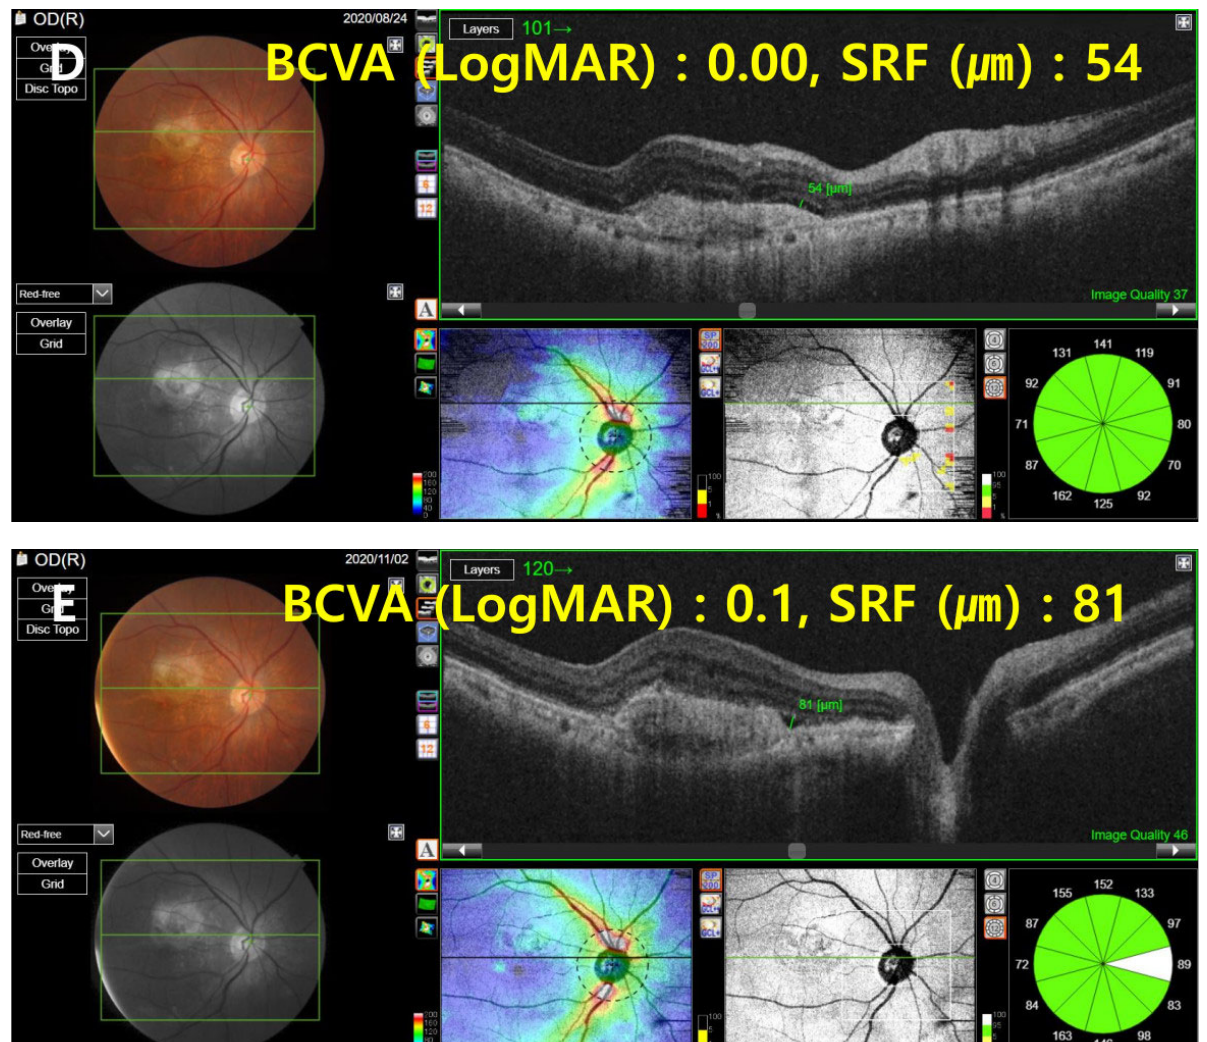
Figure 4. OCT change in a patient with neovascular age-related macular degeneration. ( A ) Baseline OCT image. ( B ) OCT image at the time of delayed injection. ( C ) Two months after the delayed injection. ( D ) Four months after the delayed injection. ( E ) Six months after the delayed injection. At the time of delayed injection, the BCVA was worse than the baseline, and the maximum SRF height (green line) was higher. After resumption of treatment, the BCVA and SRF height gradually improved, but eventually did not recover to baseline levels after 6 months after the treatment delay.